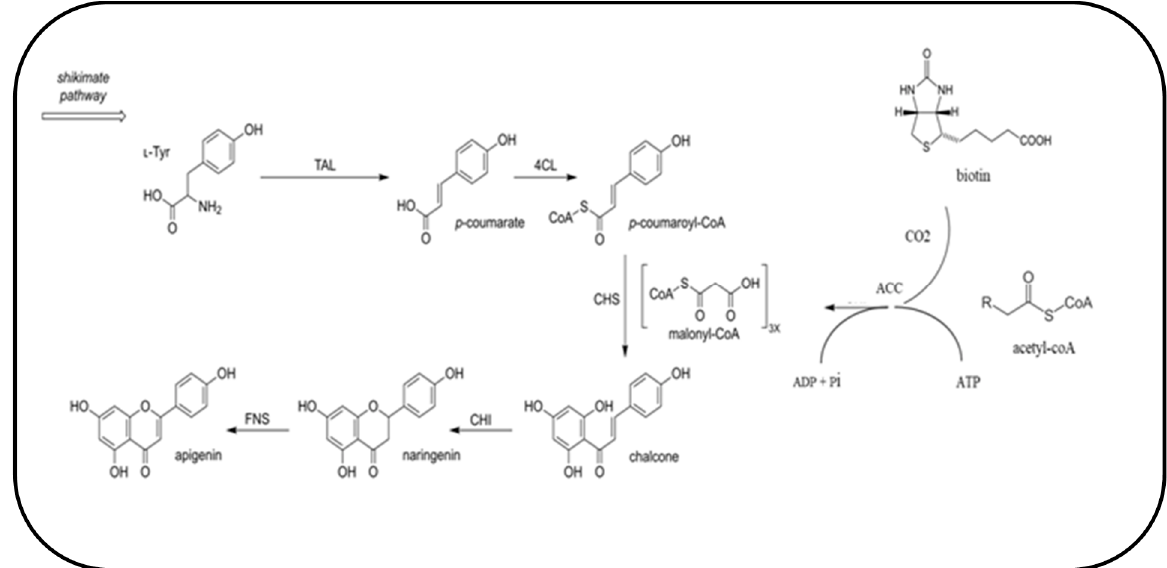
Figure 1. Biosynthetic pathway of apigenin in Streptomyces albus- pAPI. The gene coding for TAL enzyme, together with the genes coding for 4CL, CHS, CHI and FNS enzymes, were cloned in a plasmid, called pAPI; a strategy never reported before